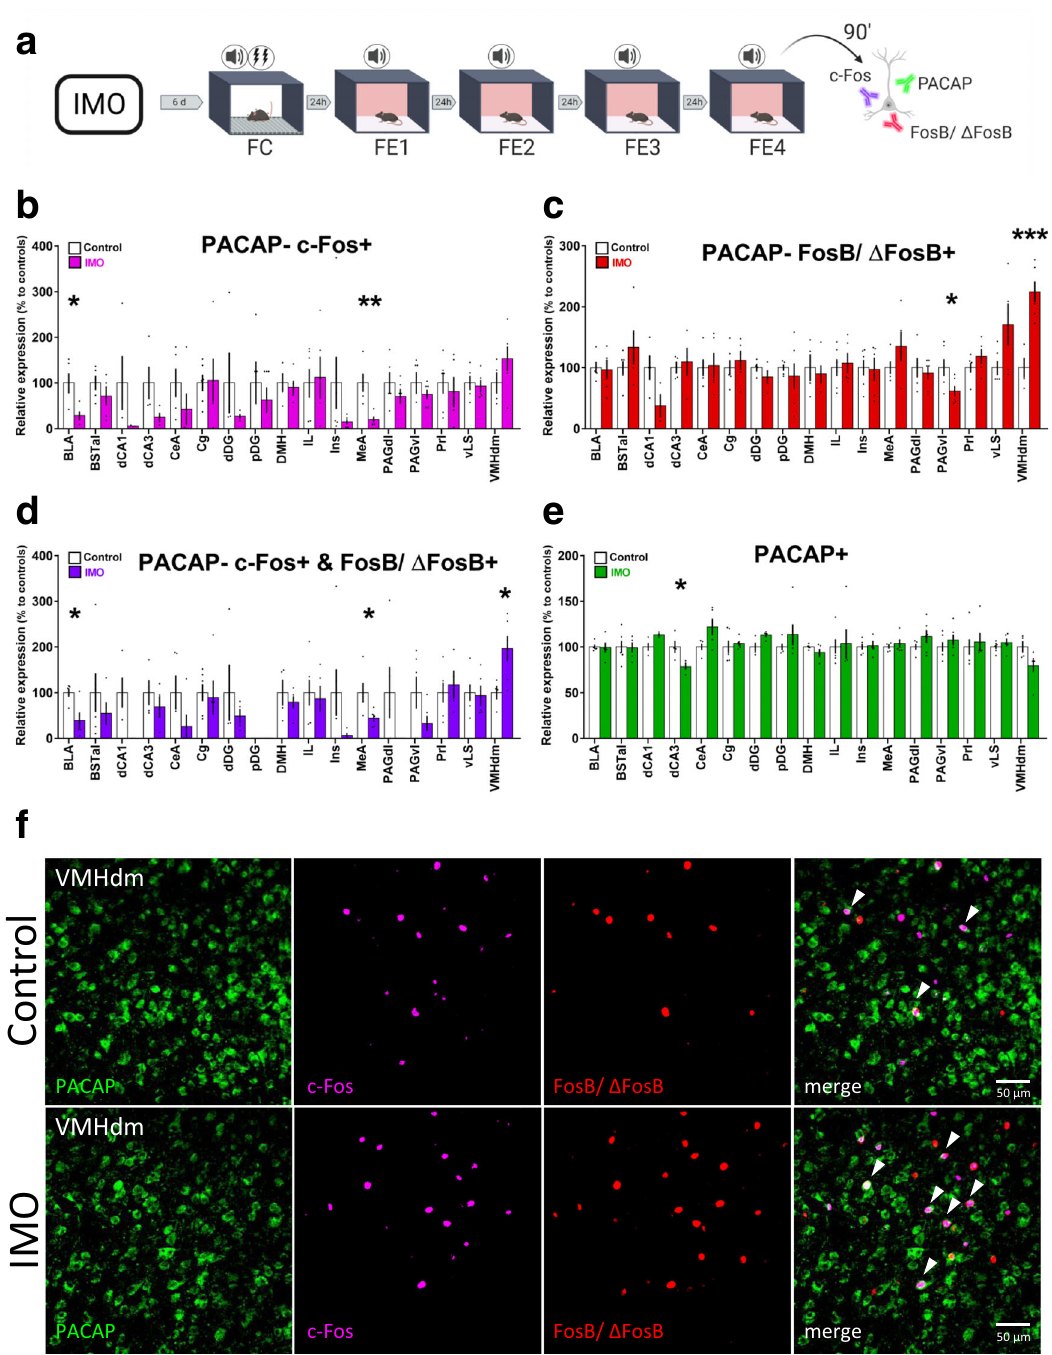
Fig. 3 Immobilization stress induces changes in PACAP + neuronal activation after a fear extinction task. a Schematic representation of the behavioral and immunohistochemical methods. b Quanti fi cation of cellular colocalization of PACAP-c-Fos + (BLA and MeA n = 5 per group) (BLA: P = 0.023, MeA: P = 0.005). c Quanti fi cation of cellular colocalization of PACAP-FosB/ Δ FosB + (PAGvl n = 6 per group, VMHdm control: n = 4, IMO: n = 6) (PAGvl: P = 0.037, VMHdm: P = 0.001). d Quanti fi cation of double colocalization of PACAP-c-Fos + and FosB/ Δ FosB + (BLA and MeA n = 5 per group; VMH control: n = 4, IMO: n = 6) (BLA: P = 0.015, MeA: P = 0.040, VMHdm: P = 0.030). e Quanti fi cation of PACAP + cells (dCA3 n = 4 per group) (dCA3: P = 0.028). f Representative confocal images of PACAP, c-Fos, FosB/ Δ FosB colocalization in the VMHdm. White arrowheads signal triple colocalization. Scale bar 50 μ m. Results are presented as relative expression compared to controls (in %) and extracted from cells per mm 2 normalized to DAPI. Data are presented as means ± SEM. * P ≤ 0.05, ** P ≤ 0.01, *** P ≤ 0.001. Two-tailed t tests or Mann – Whitney ’ s U tests were used. BLA basolateral amygdala, BSTal bed nucleus of the stria terminalis anterolateral part, dCA1 dorsal CA1, dCA3 dorsal CA3, CeA central amygdala, Cg cingulate cortex, dDG dorsal dentate gyrus, pDg posterior dentate gyrus, DMH dorsomedial hypothalamus, FC fear conditioning, FE fear extinction, IL infralimbic cortex, IMO immobilization stress, Ins insular cortex, MeA medial amygdala, PAGdl dorsolateral periaqueductal gray, PAGvl ventrolateral periaqueductal gray, Prl prelimbic cortex, vLS ventral lateral septum, VMHdm ventromedial hypothalamus dorsomedial nucleus. Source data are provided as a Source Data fi